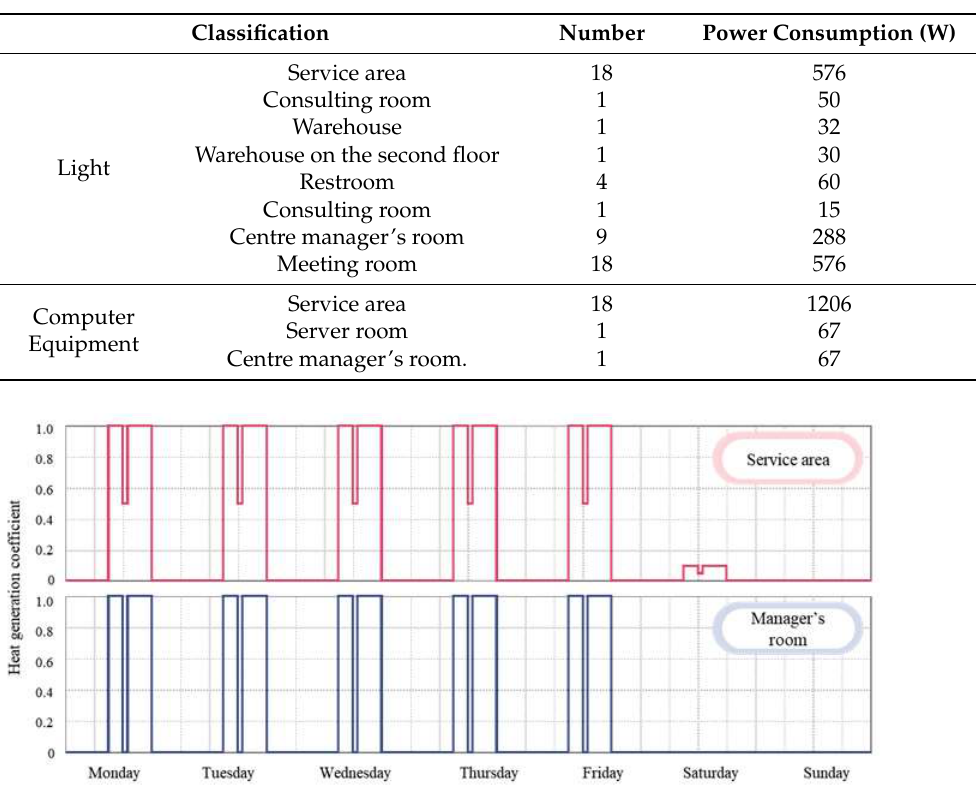
Table 3. Heat sources and power consumption in the experimental building.